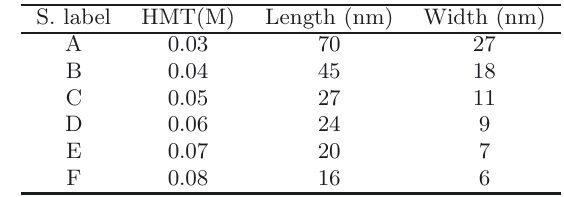
Fig. 4. XRD spectra of TiO 2 nanorice prepared using different HMT concentrations, namely 0.03 (A), 0.04 (B), 0.05 (C), 0.06 (D), 0.07 (E) and 0.08 M (F). AHT was fixed at 0.05 M. Table 1. TiO 2 nanorice prepared using different HMT con- centrations with AHT fixed at 0.05